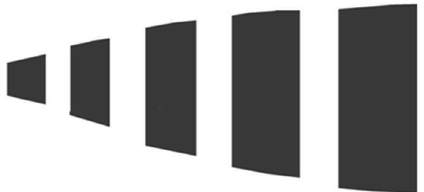
Figure 11: The rubber is cut according to the shape of the tail—the first 2 stripes from the tail fin (left on this picture are 20mm wide and the remaining ones are 25 mm wide).